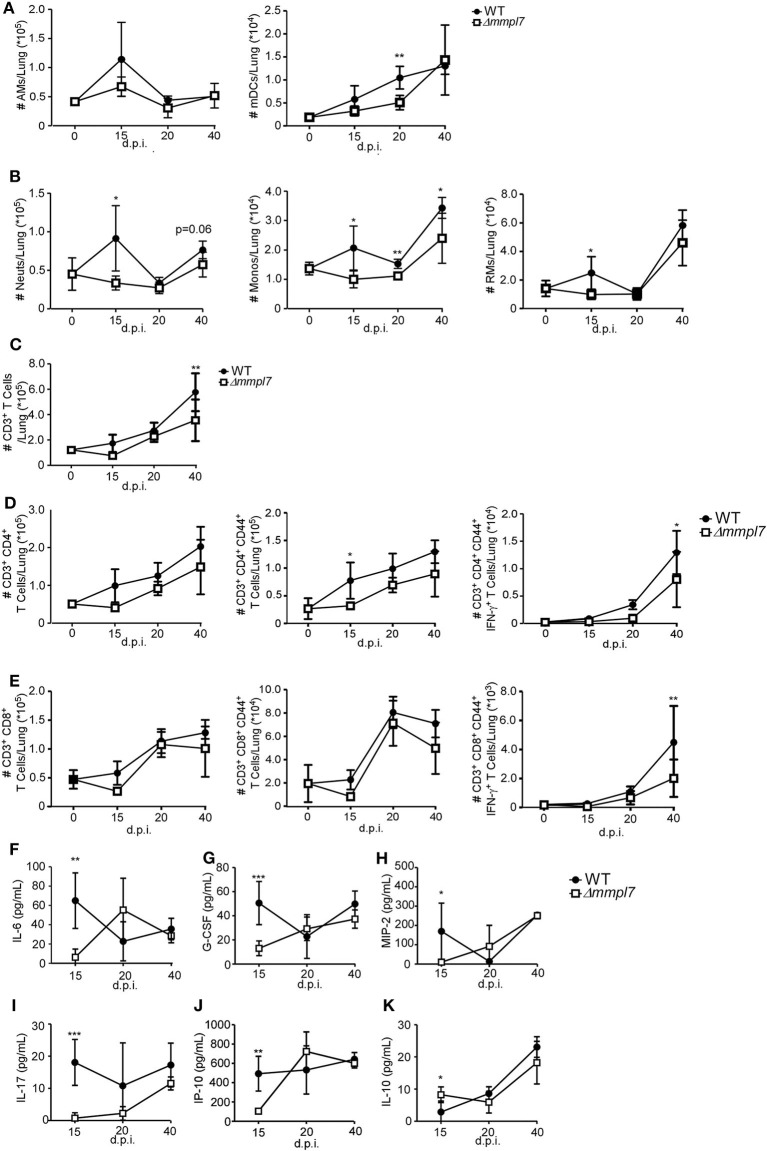
Δmmpl7 mutant Mtb limits myeloid cell accumulation in the lung: Sex and age matched C57BL/6 mice were infected with 100 CFU Mtb Erdman WT or 500 CFU Δmmpl7. Single cell suspensions were processed from infected lungs and immune cell subsets were analyzed by flow cytometry. (A) tissue resident myeloid and (B) recruited myeloid cell accumulation in the Mtb-infected lungs was determined at indicated time points. (C) CD3+ lymphocytes, (D) CD4+ or (E) CD8+ T cells were determined using flow cytometry. (F–K) Protein levels of inflammatory cytokine and chemokines IL-6, G-CSF, MIP-2(CXCL2), IL-17, IP-10 (CXCL10), and IL-10 were determined in lung homogenates at indicated time points. Infected groups (n = 5) comparing WT Erdman and Δmmpl7 Mtb strains at individual time points were compared using Student's t-test. Individual time points within the same group were compared using 2-way ANOVA with Bonferroni post-tests. Mean and standard deviation (SD) were plotted for each group at each indicated time point. *p < 0.05, **p < 0.01, ***p < 0.001.